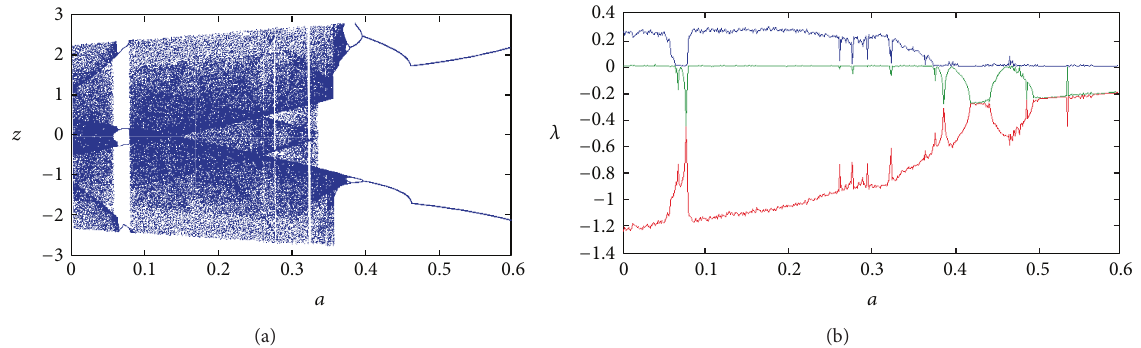
Figure8:Nonlineardynamicsofsystem(1)forspecificvalues 𝑎 = 2 versusthecontrolparameter 𝑎 .(a)Bifurcationdiagramof 𝑥 ;(b)Lyapunov exponent spectrum.